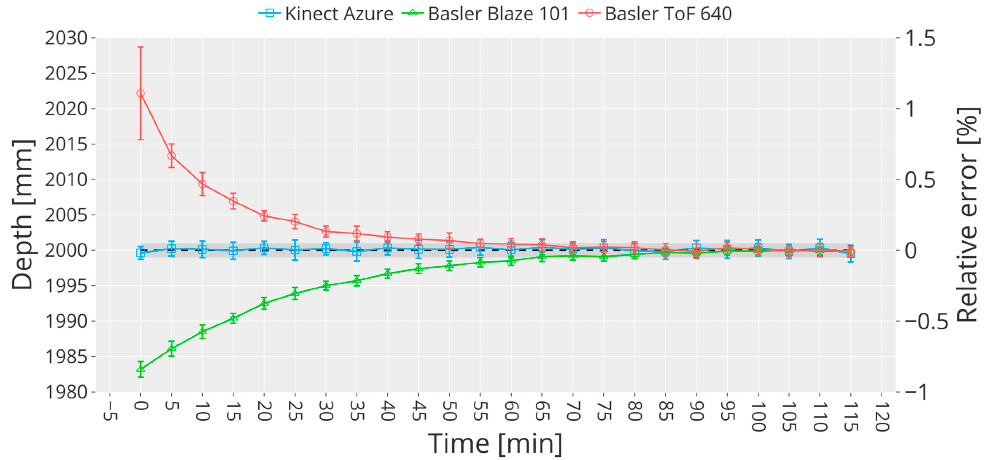
Figure 2. Temperature-related error. The plot shows the depth measurements obtained from the three ToF cameras considering a time interval of 5 min. Bias correction applied. Surprisingly, Kinect Azure does not need to warm up to obtain a stable output, mean- ing that the depth readings are not correlated with the device temperature. This result contrasts with the work presented in [40], where the authors stated that the device needed at least 60 min of warm-up. However, in our experiment, Kinect Azure achieves stable values from the beginning without the need for a warm-up time. In fact, the bias correction for Kinect Azure could have been performed considering all the 24 data points 𝑑 (cid:3047) in Equa- tion (1) instead of the last five only since they were not significantly different. The exper- iment was performed twice to confirm this finding, highlighting the robustness of our measuring method in contrast with reference [40]. A possible reason to explain why we obtained a significantly different result is that the bias was not corrected in [40]. Further- more, in our experiment, the relative distance camera-target was 𝐷 (cid:3041) (cid:3404) 2 m , while in [40], they used 𝐷 (cid:3041) (cid:3404) 0.8 m . Environmental characteristics could have impacted the measure- ment, for example, if the ambient illuminance interfered with Azure’s IR rays. In our case, even if the camera is used continuously for almost 120 min, the output is stable in terms